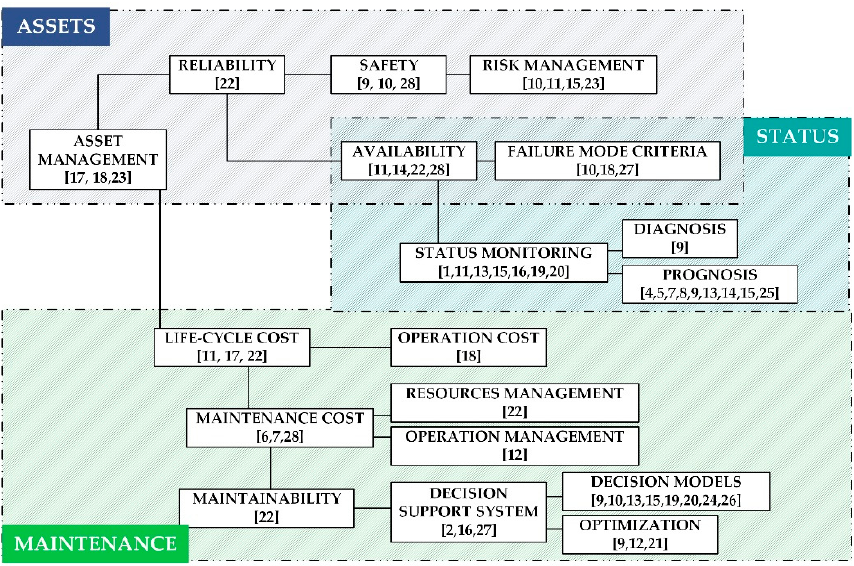
Figure 3. Prescriptive maintenance domains.